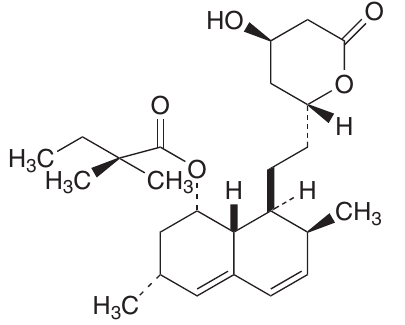
FIGURE 1 - Structure of